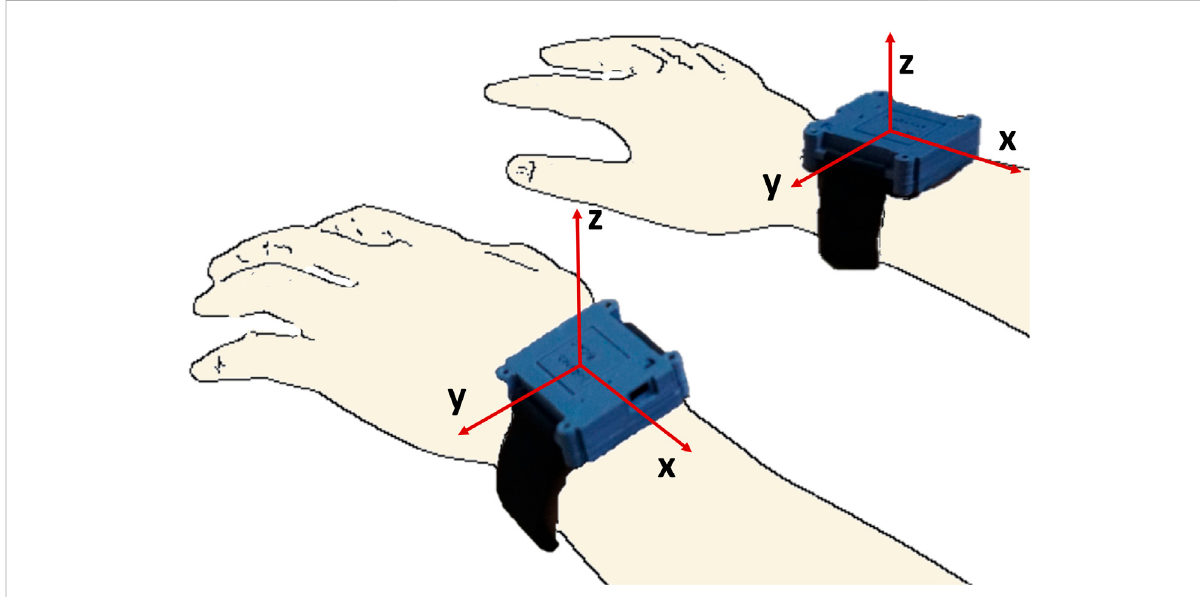
FIGURE 1 IMU watches with the axes of the accelerometers for each of the two watches.